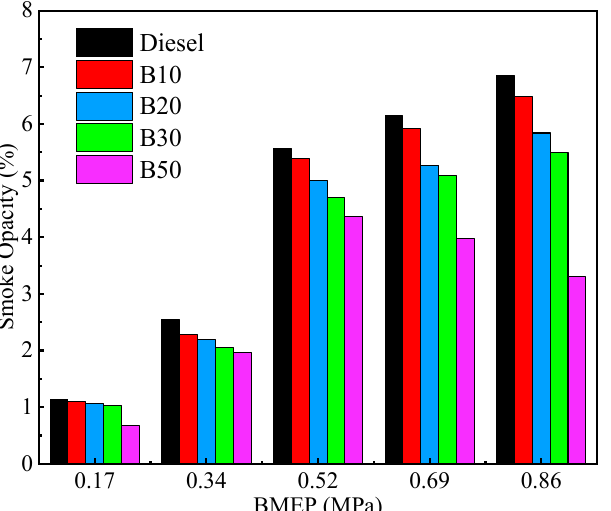
Figure 32. Smoke emission comparison of biodiesel blends and diesel under different BMEPs [169].